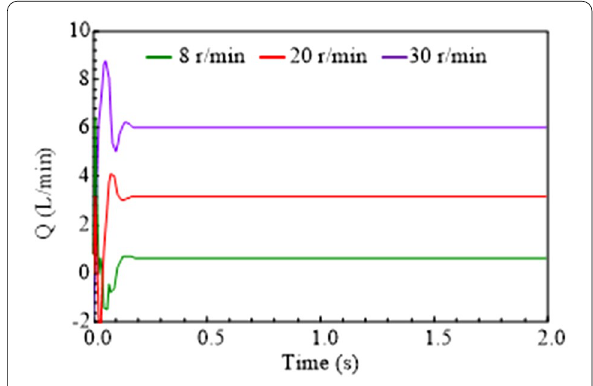
Figure 16 Flow rate through bypass orifices Figure 17 Pressure of the equivalent load